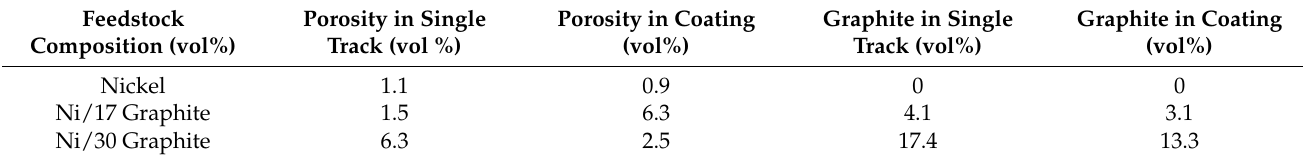
Table 4. Graphite content and porosity in the coatings prepared for wear testing. Feedstock Porosity in Single Porosity in Coating Graphite in Single Graphite in Coating Composition (vol%) Track (vol %) (vol%) Track (vol%) (vol%) Nickel 1.1 0.9 0 Ni/17 Graphite 1.5 6.3 3.1 Ni/30 Graphite